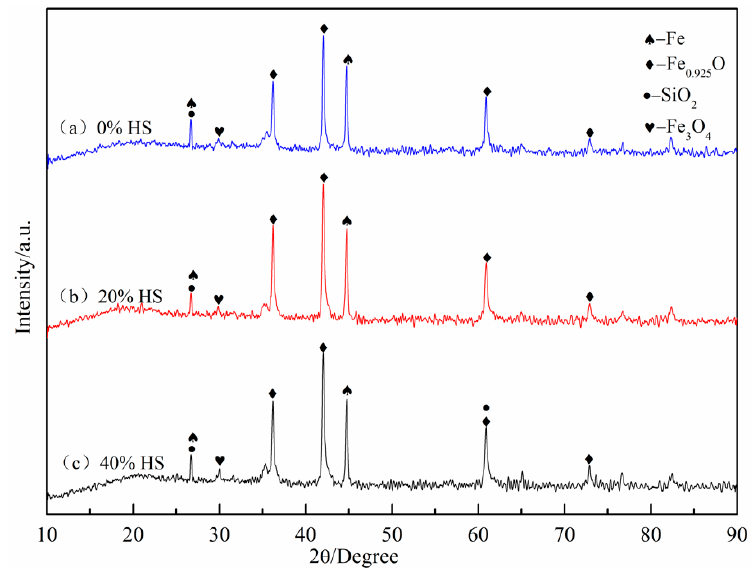
Figure 13. XRD pattern of the oxidized pellets after reduction swelling with different dosages of sea sand